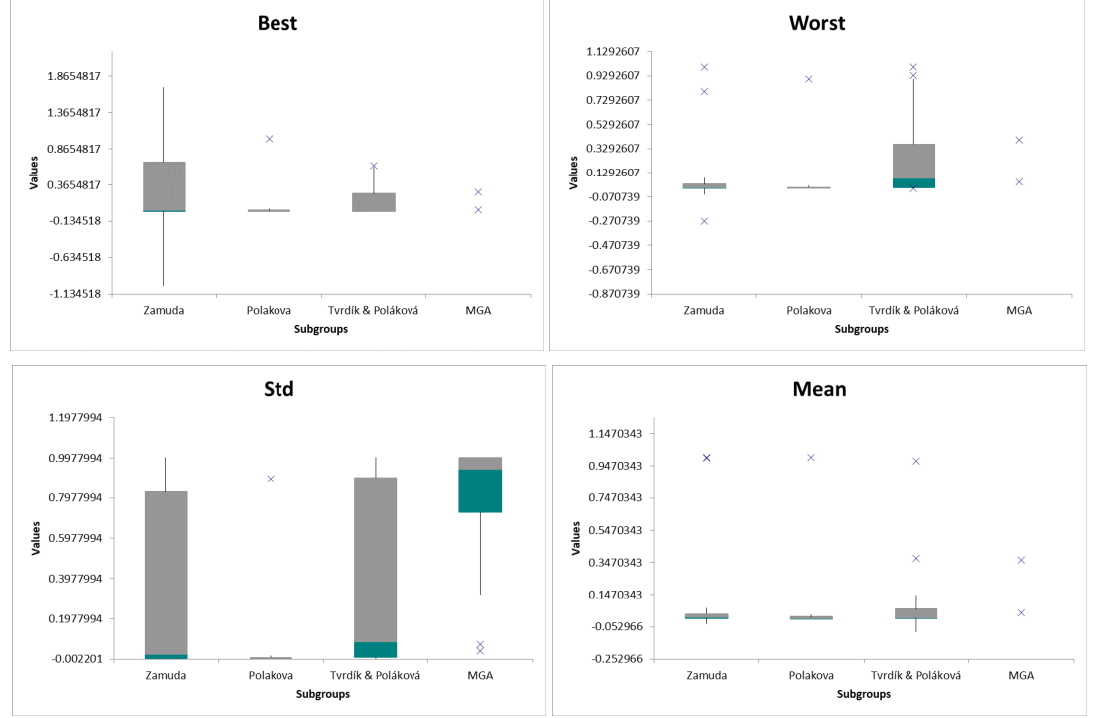
Figure 10. Box plots of the ANOVA for the 100-dimensional problems.